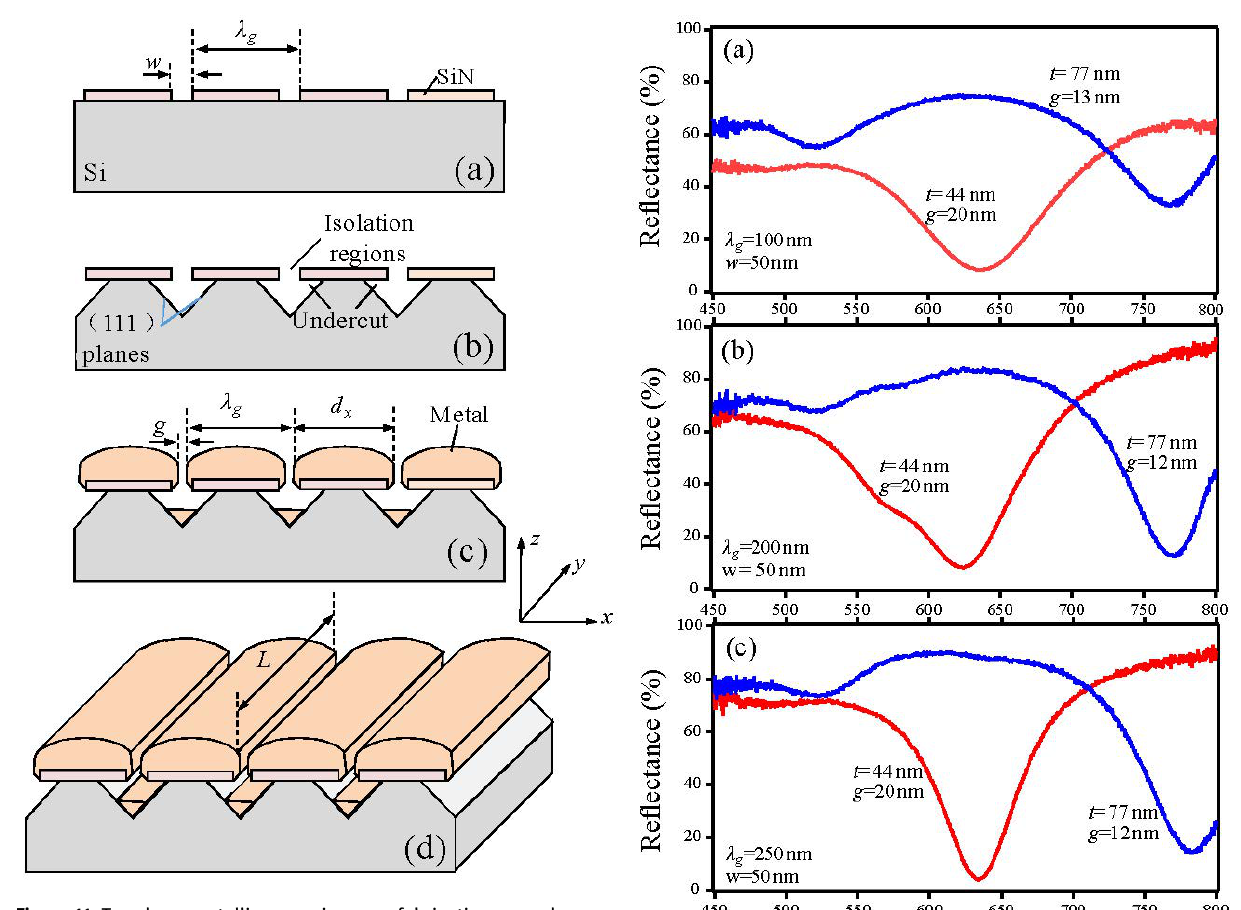
Figure 11: Top-down metallic nanowire array fabrication procedure and relevant dimensions (not to scale). (a) SiN mask layer with the length direction aligned to the [110] direction of a (100) sili- con wafer. (b) Anisotropic etching of silicon to create the triangular undercut grooves. (c) Metal deposition using conventional vac- uum deposition technology. (d) Finished metallic nanowire array. Adapted from Ref. [45].